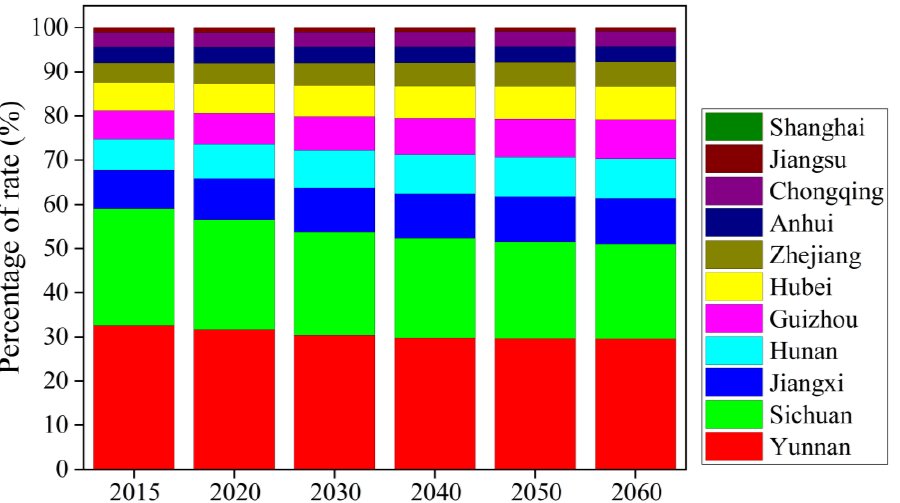
Figure 4. Predicted variations in the proportion of forest biomass C storage from 2015 to 2060 in each province and municipality.